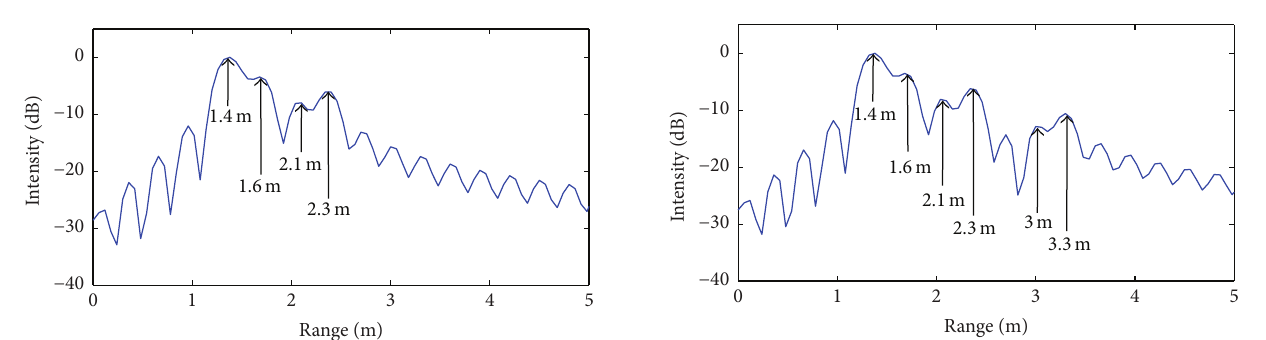
Figure 9: Range profile obtained from CS procedure (second scenario: 𝑁 = 6